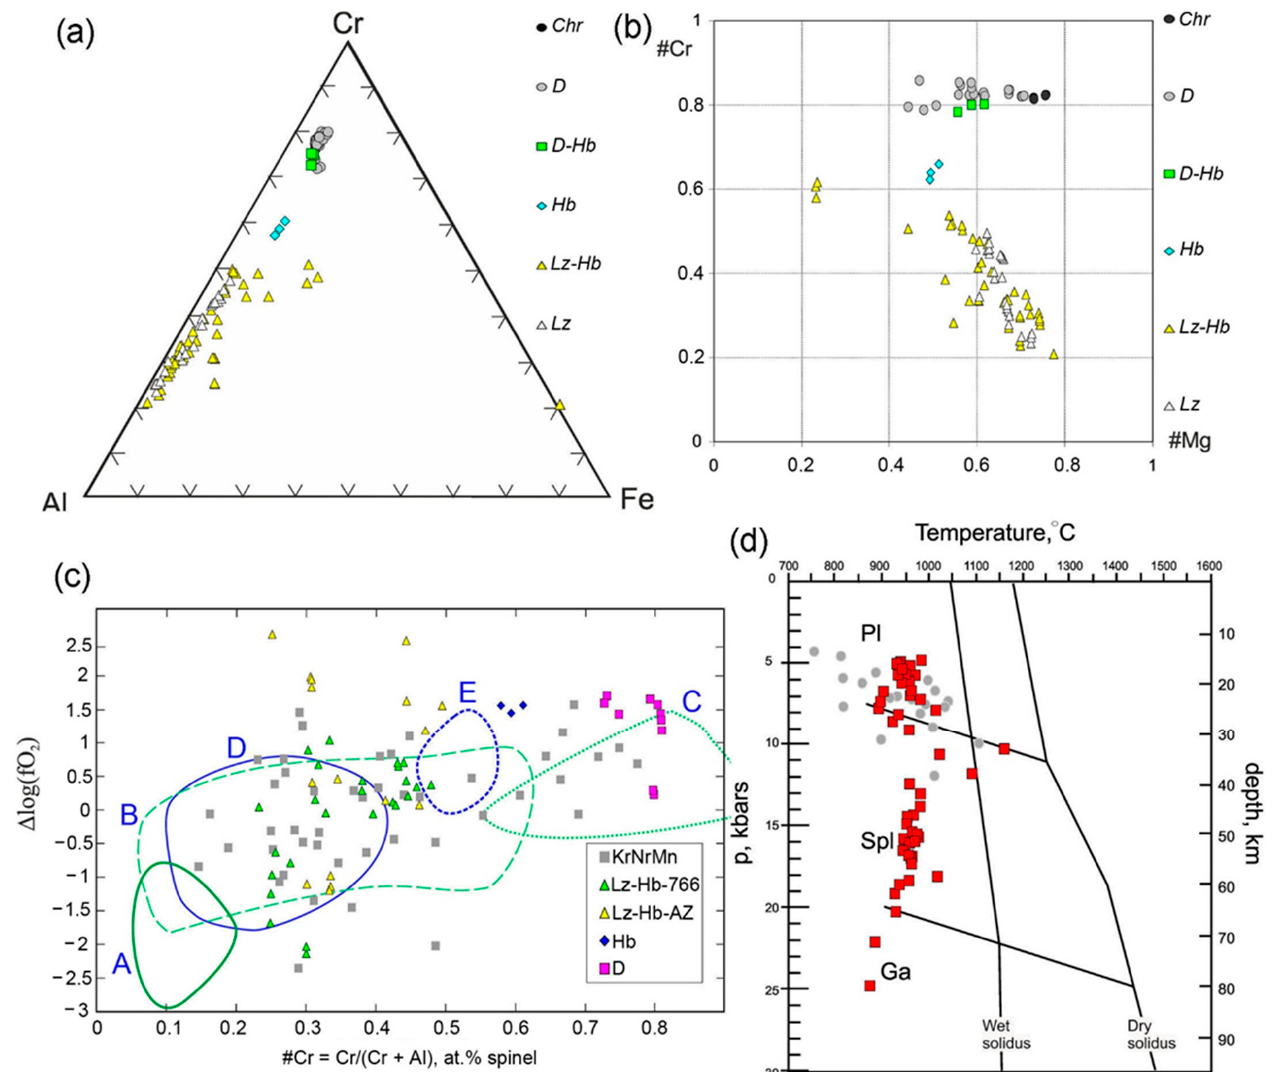
Figure 7. ( a )—Al–Cr–Fe diagram for three-valent cations of Cr-spinel; ( b )—#Cr = Cr/(Cr + Al) vs. #Mg = Mg/(Mg + Fe) diagram for Cr-spinel grains; ( c )—#Cr vs. ∆ log(fO 2 ) diagram; fields: 1–3, peridotite xenoliths: 1, primitive; 2, slightly metasomatized; 3, strongly metasomatized; 4, 5, abyssal peridotites with spinel (4) and plagioclase (5), after [42]; KrNrMn—lherzolite-type massifs of South Urals (Kraka, Nurali, Mindyak); Lc-Hb-766—peridotites of well 766; Lz-Hb-AZ—peridotite from Almaz-Zhemchuzhina deposit area; Hb—harzburgite, D—dunite; ( d )—Diagram of PT formation conditions of mineral assemblages using pyroxene geothermometers and geobarometers [43,44]; gray points are samples of lherzolite-type massifs of South